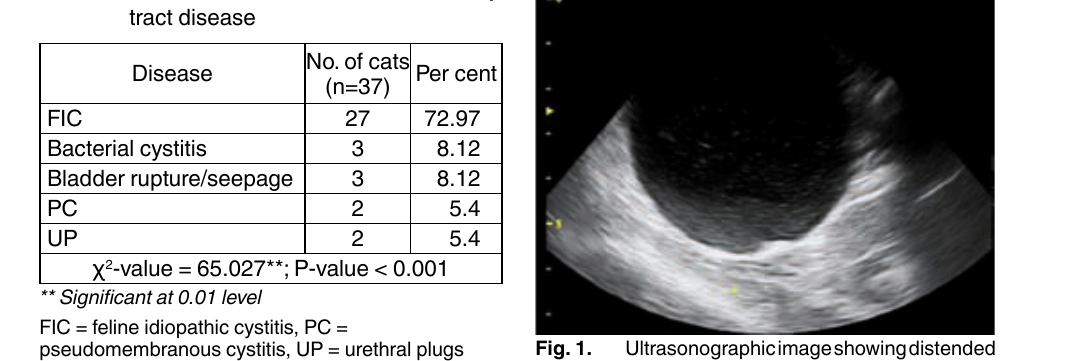
table 4. Occurrence of feline lower urinary